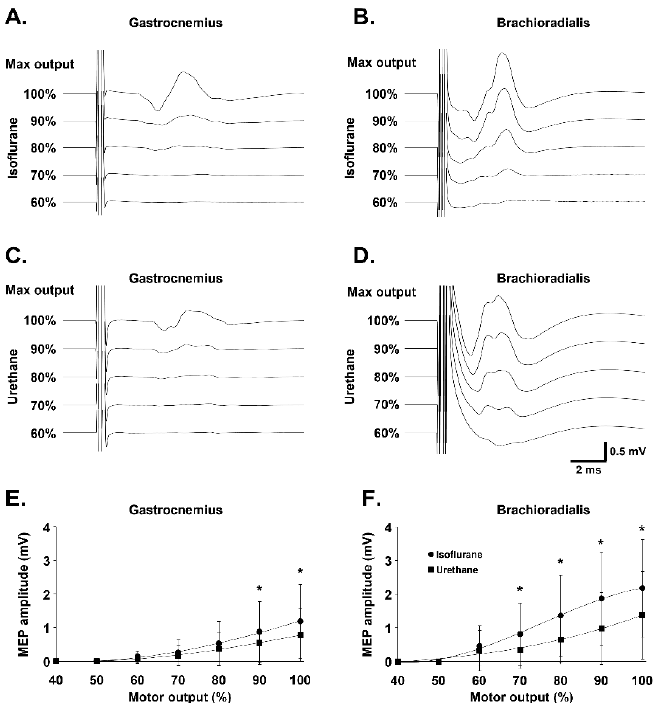
Figure 2. Amplitude of MEP in gastrocnemius and brachioradialis muscles under isoflurane or urethane anesthesia: Representative traces of gastrocnemius and brachioradialis motor evoked potentials (MEP) under isoflurane ( A , B ) or urethane ( C , D ) anesthesia for MO ranging from 60% MO to 100% MO. Variation in motor evoked potentials (MEP) amplitude, depending on motor output (%) and anesthetic (isoflurane vs. urethane) in gastrocnemius ( E ) and brachioradialis ( F ) muscles. * isoflurane compared to urethane (paired t test, p < 0.05).